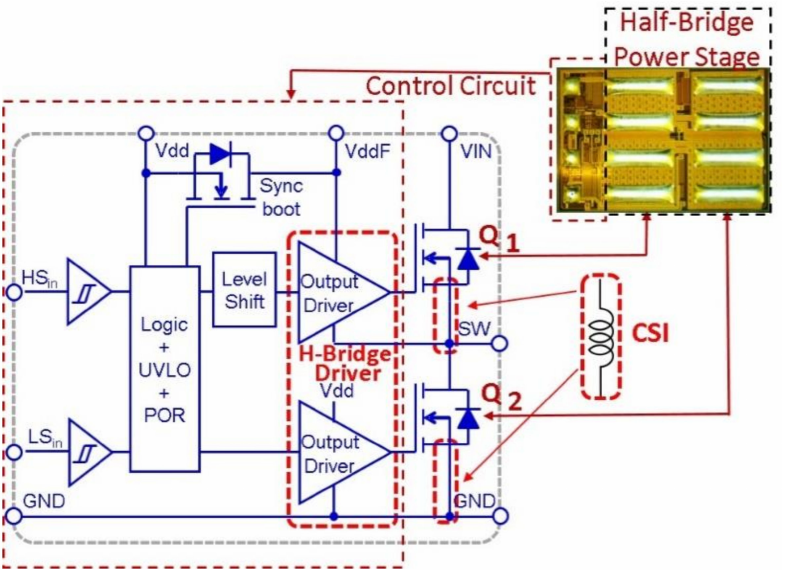
Figure 4. Principle scheme of a monolithic half-bridge GaN FETs with a driver circuit. The chip view is highlighted with the solderable bars package solution. The common source inductance position is depicted.